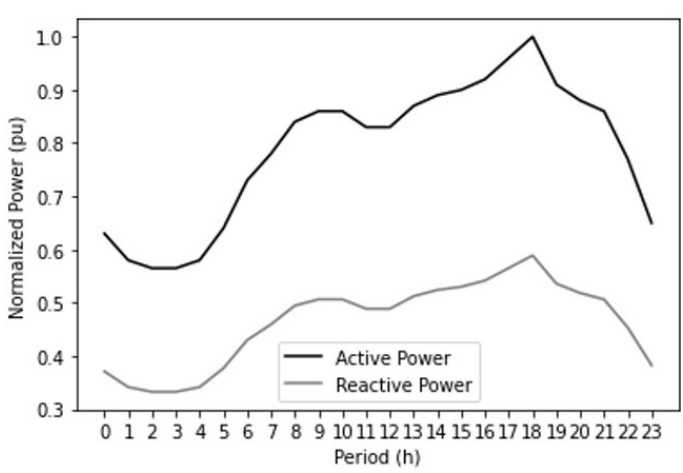
Figure 5. Behavior of the load curve in the